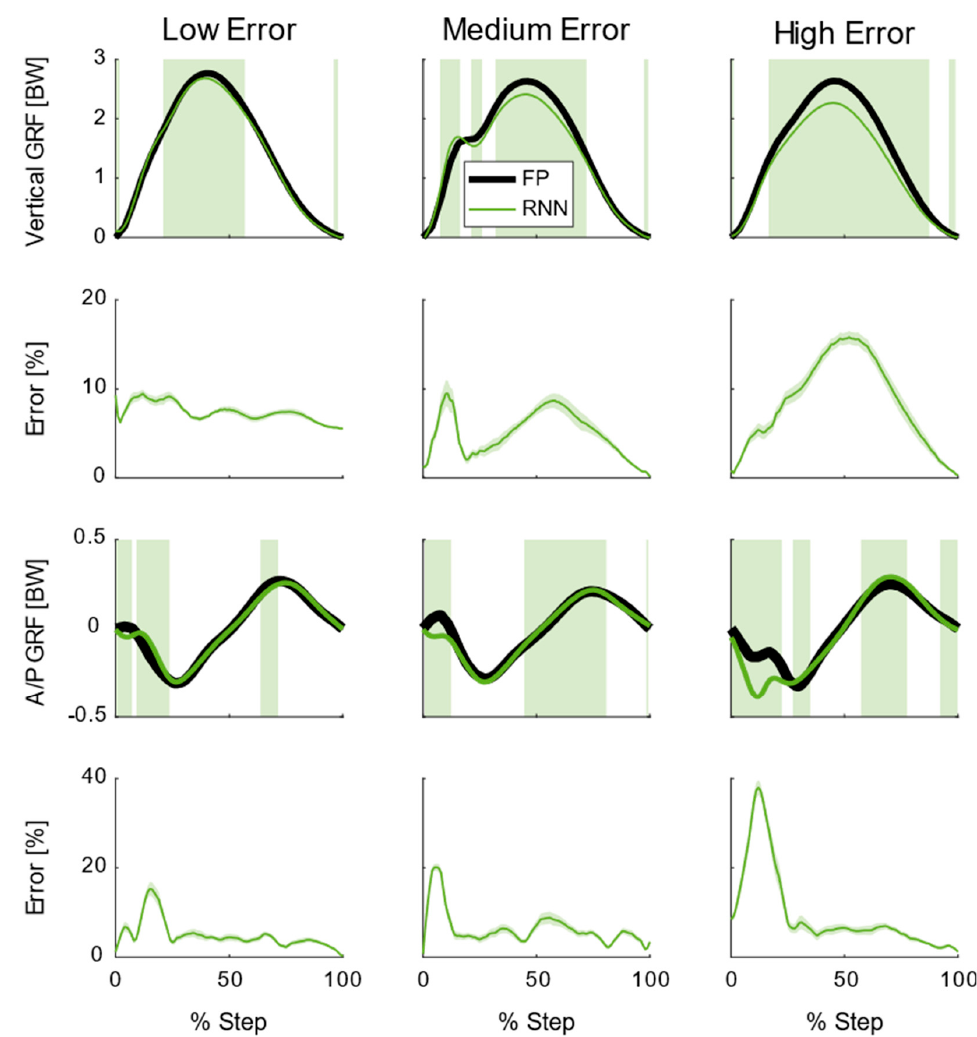
Figure 6. Subject − averaged (N = 18) ground reaction forces (GRFs), model predictions, and model errors for running at 3.0 m/s on level ground. The top row shows average vertical GRF from the force platform (FP) along with average recurrent neural network (RNN) predictions. Each column represents a different subject that either had the lowest, near average, and highest average errors in the RNN prediction of vertical GRF. Areas shaded green are where there were significant differences between the FP and RNN ( p < 0.05). The second row shows the mean absolute percent error plus/minus one standard deviation for the RNN in the vertical direction. The third row shows average anterior/posterior (A/P) GRF from the FP and average RNN predictions. Each column represents a different subject that either had the lowest, near average, and highest average errors in the RNN prediction of A/P GRF. Areas shaded green are where there were significant differences between the FP and RNN ( p < 0.05). The bottom row shows the mean absolute percent error plus/minus one standard deviation for the RNN in the A/P direction.